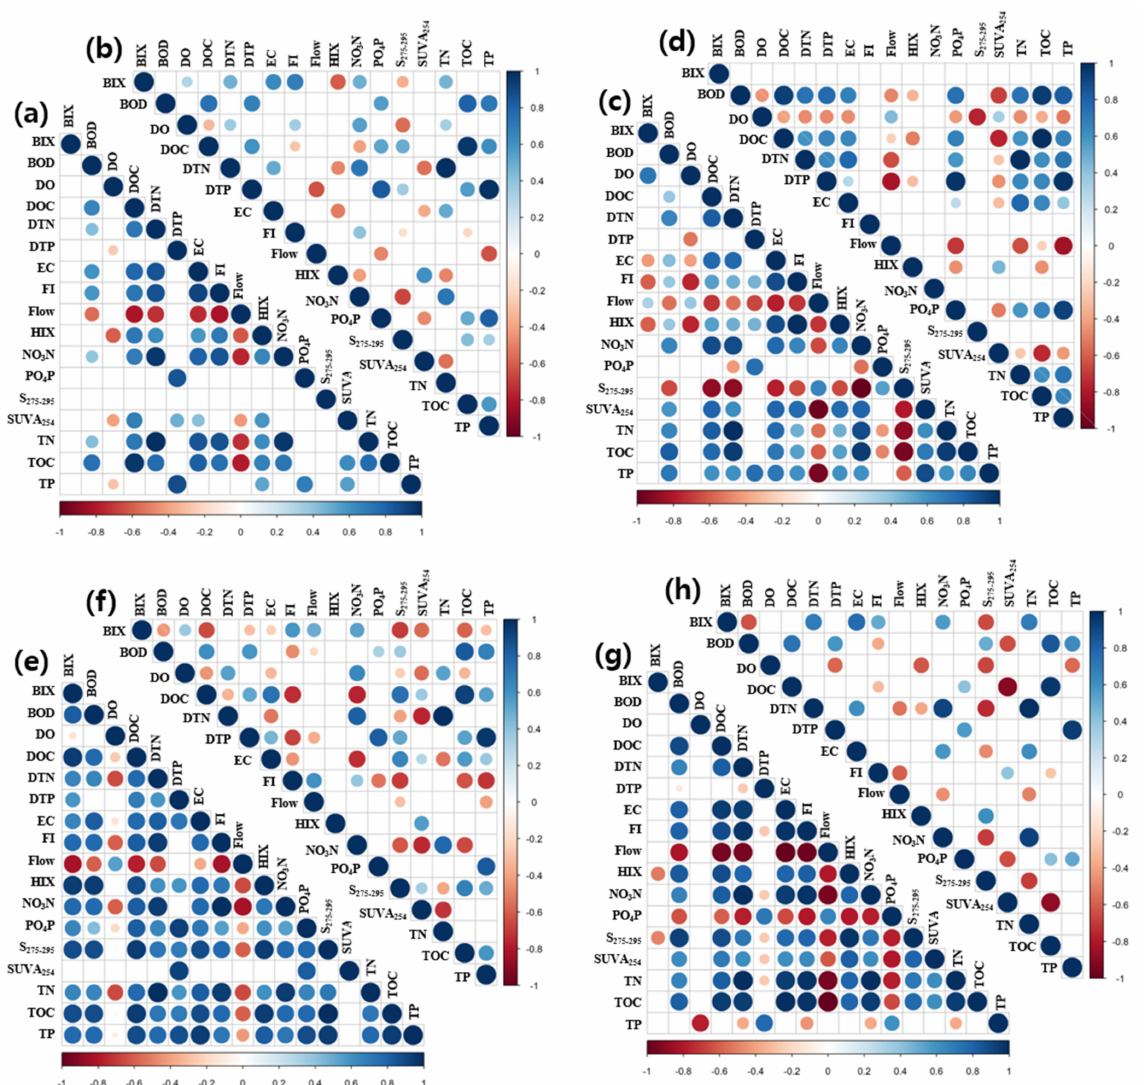
Figure 8. Comparison of correlation coefficients among flow rates, water quality parameters, and spectroscopic indices according to the classified clusters and different farming seasons ( p < 0.01); all periods, Cluster 1 (C1) ( a ), Cluster 2 (C2) ( b ); pre-planting season, C1 ( c ), C2 ( d ); planting season, C1 ( e ), C2 ( f ); post-harvesting season, C1 ( g ), C2 ( h